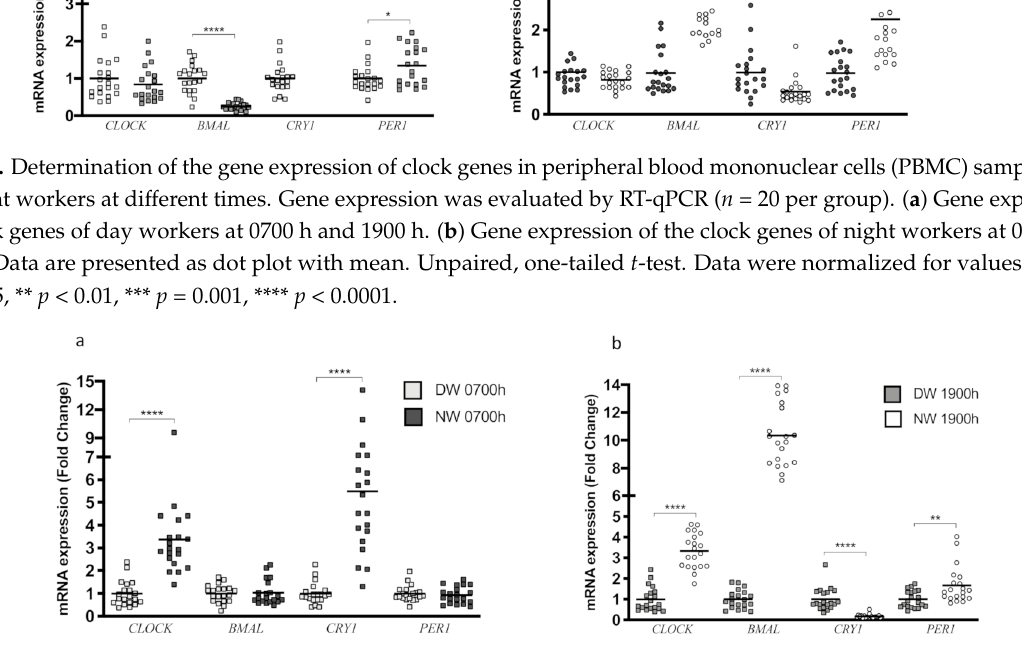
Figure 4. Determination of the gene expression of clock genes in PBMC samples of day and night workers. Gene expression was evaluated by RT-qPCR ( n = 20 per group). ( a ) Gene expression of the clock genes at 0700 h compared DW and NW. ( b ) Gene expression of the clock genes at 1900 h compared DW and NW. Data are presented as dot plot with mean. Unpaired, one-tailed t -test. Data were normalized for DW. ** p < 0.01, **** p < 0.0001. ( n = 20 per